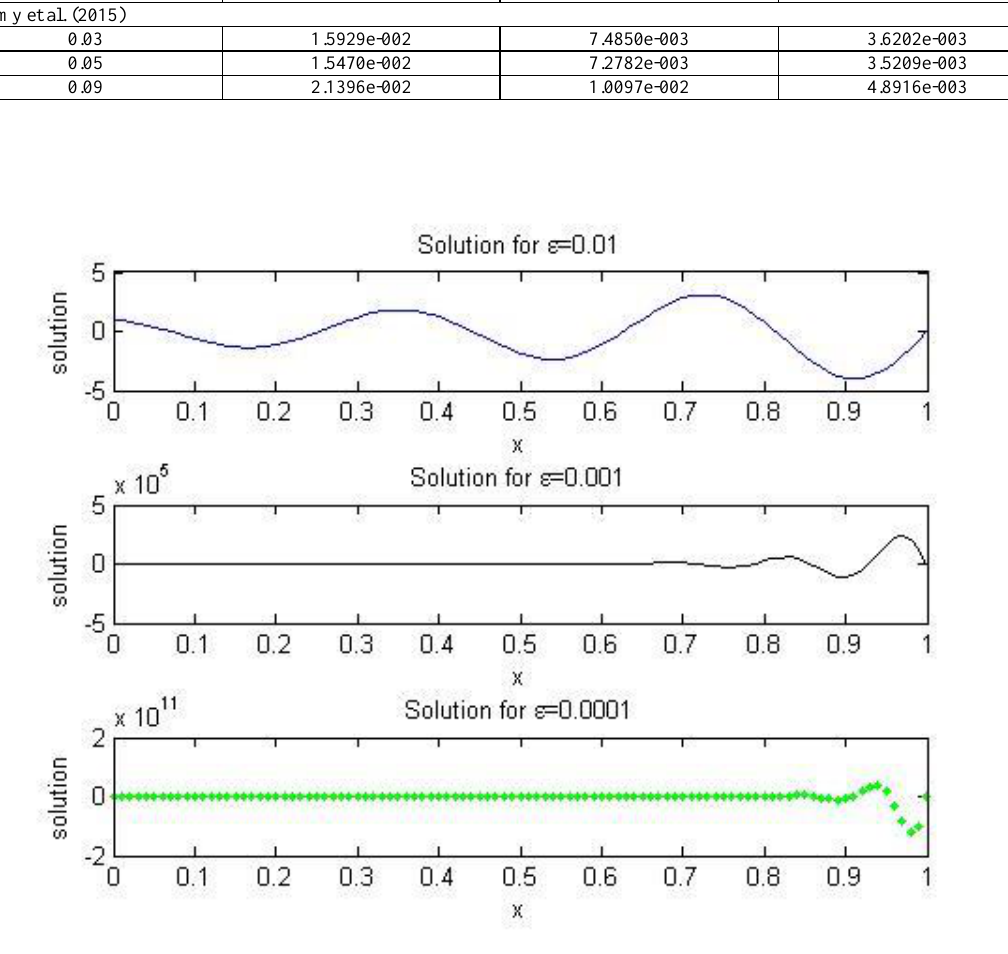
Figure 4. Solution of Example 4 for various values of